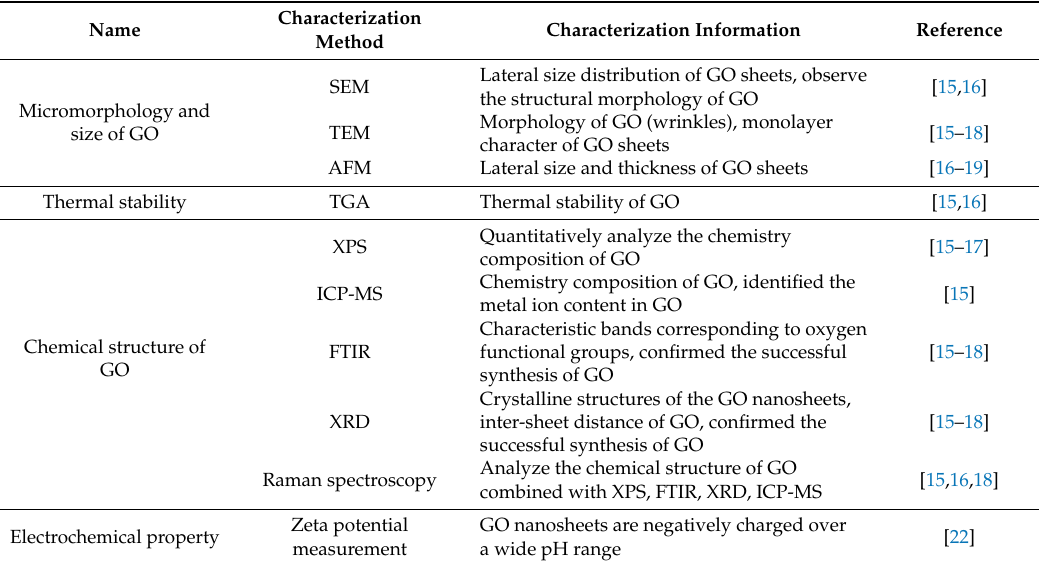
Table 2. Methods for the characterization of